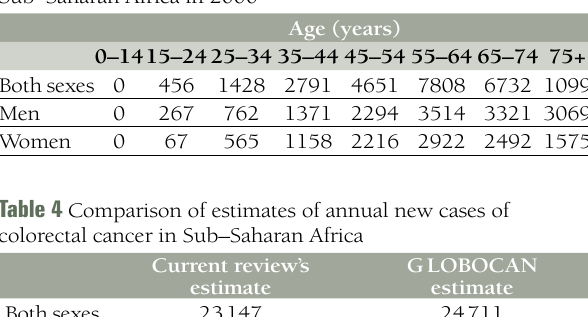
Table 3 Annual number new cases of colorectal cancer in